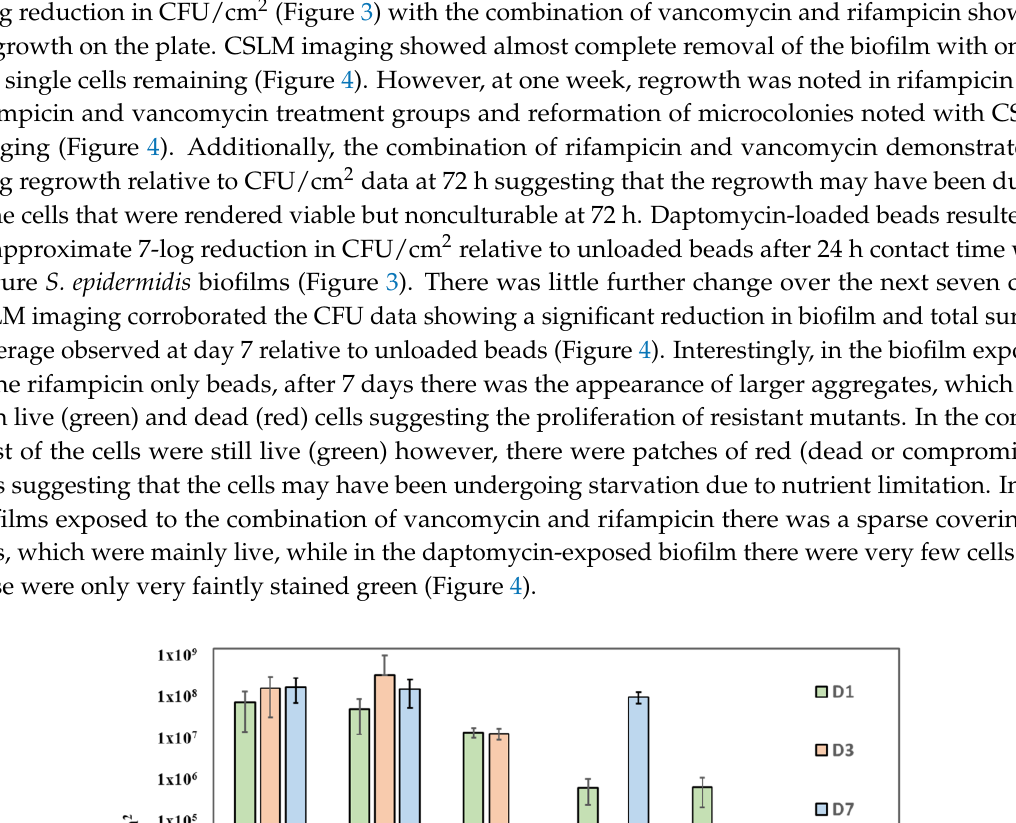
Figure 4. Representative CSLM images showing S. epidermidis ATCC 35984 biofilm (live cells stained green and dead and membrane compromised cells stained red or yellow) following treatment for 24 h and 1 week with unloaded beads (negative control) and beads loaded with rifampicin (Rifampin), rifampicin and vancomycin, and daptomycin. Scale bars: 25 µm. 4. Discussion With the exception of clindamycin, the calcium sulfate in combination with the antibiotics tested, set hard, maintaining its function as a void filler. All antibiotics used in this study were IV formulations. Antibiotic capsules and tablets contain different excipients to IV formulations and these may create additional risks if administered locally. Ceftriaxone, although included here, is contraindicated when mixing with a calcium-containing product such as Ringer’s solution, Hartmann’s solution or parenteral nutrition containing calcium. The reason for this contraindication is the risk of crystalline precipitates forming in the lungs and kidneys. Although this risk is for IV